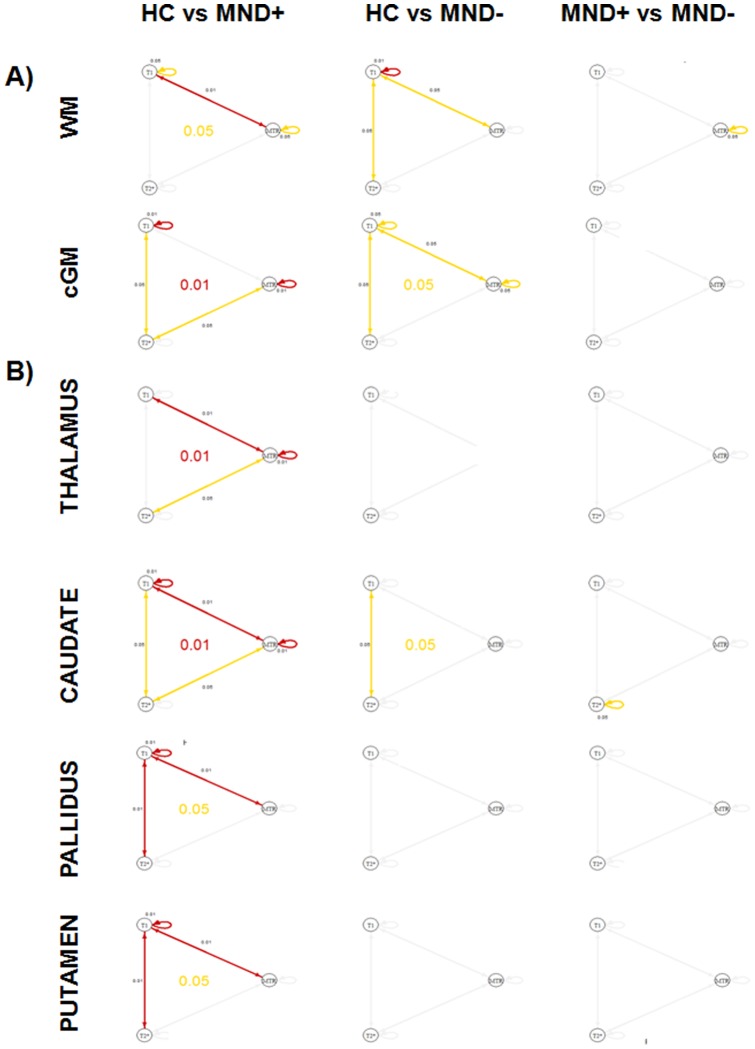
Graphs showing the respective significance in each ROI for univariate analysis (loop), bivariate analysis (straight line) and multivariate analysis (central circle).Red color indicates p≤0.01 and yellow color indicates p≤0.05. A) hypothesis 1, B) hypothesis 2.